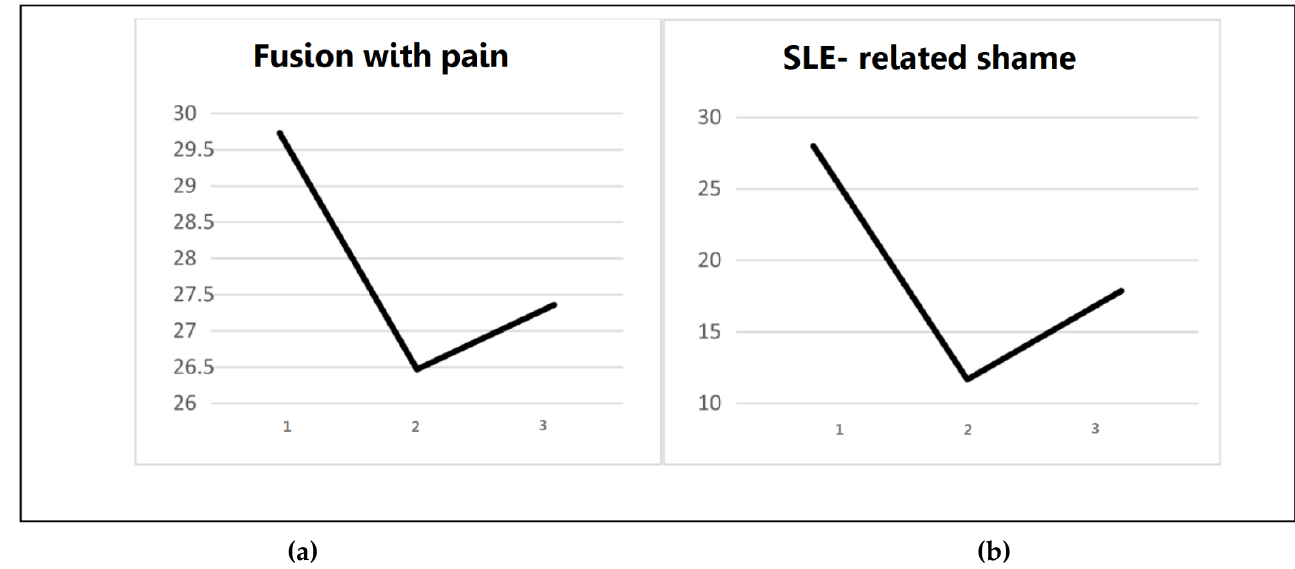
Figure 3. Long- Term effects of SLE- related Shame and Cognitive Fusion with Pain. Note: Measurements at pre- intervention (1); post-intervention (2); 6-month follow-up (3). ( a ) Follow- up effect of SLE- related shame among MBSR group; ( b ) Follow-up effect of Fusion with pain among MBSR group.